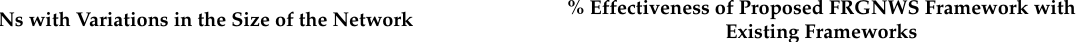
Table 7. The average % effectiveness of the proposed novel framework for the number of RNs metric with variations in the network size.